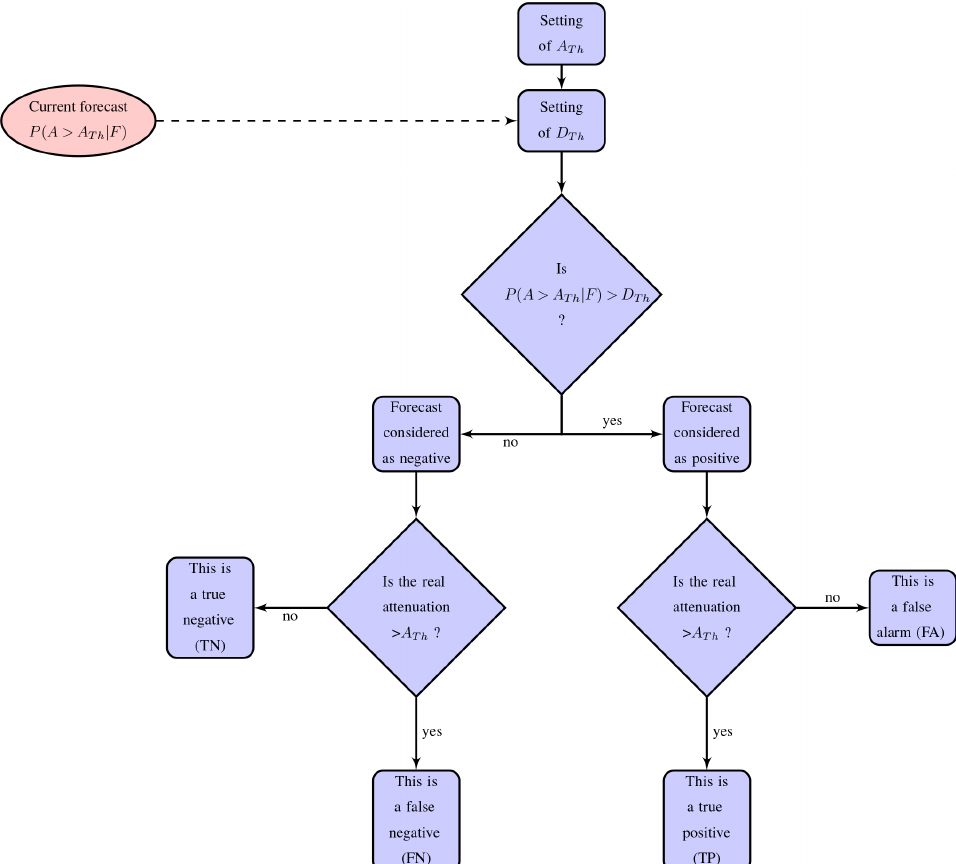
Figure 7. Block diagram of the discrimination process between positive and negative